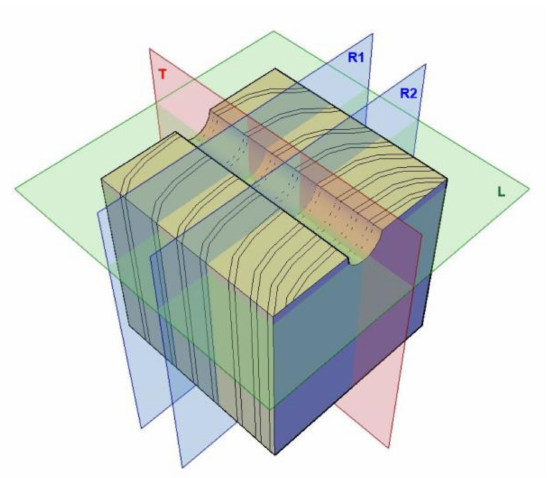
Figure 12. The schematic view of considered sections: R, T, and